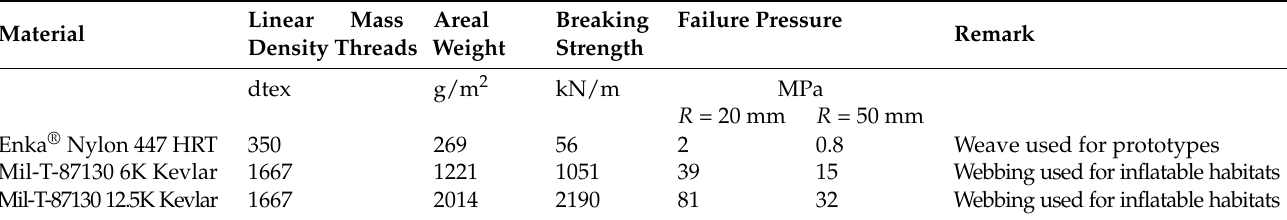
Table 5. Failure pressures for different materials and areal